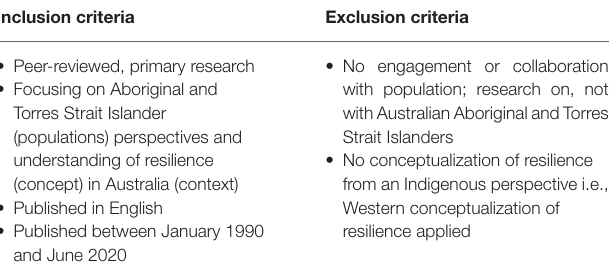
TABLE 1 | Inclusion and exclusion criteria for selecting